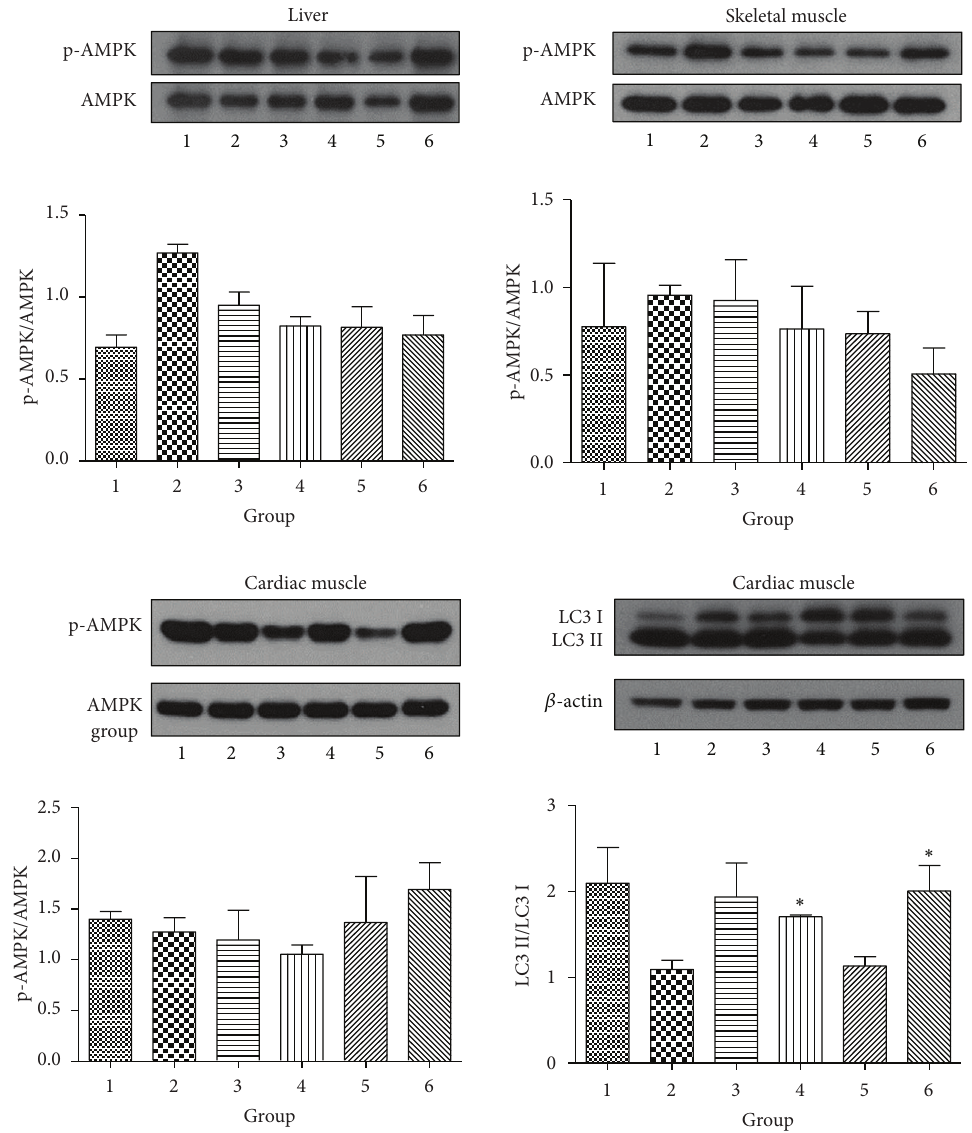
Figure 7: Representative images of the immunoblotting of AMPK in liver, skeletal muscle, cardiac muscle, and LC3 in cardiac muscle. The levels of LC3 II exhibit a significant increase in Groups 4 and 6 compared with that in Group 2, and such trend can also be seen in Group 3. On the other hand, no significant difference in p-AMPK is found in liver, skeletal muscle, or cardiac